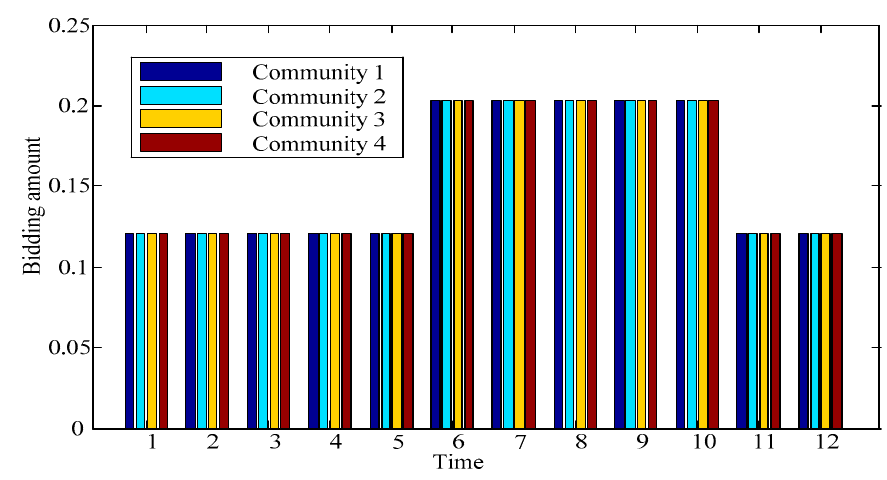
Figure 6. Optimal bidding amount of each community in the 1st week.